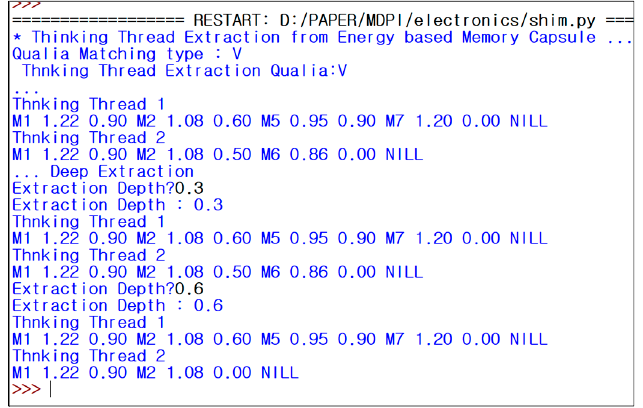
Figure 14. Thinking Thread Extraction by Qualia Matching and Deep Extraction.